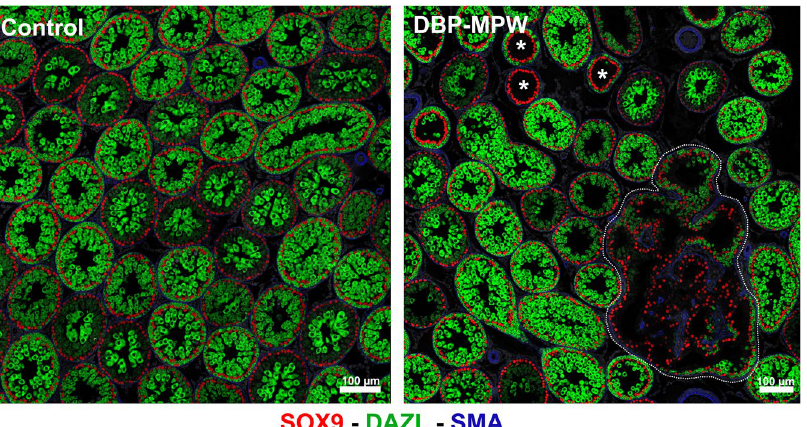
Figure 8. Identification of focal dysgenetic areas in the testes of DBP-MPW exposed animals at postnatal day 25 (Pnd25). Sections were triple immunostained for SOX9 (red, Sertoli cells), DAZL (green, germ cells), and smooth muscle actin (blue, peritubular myoid cells and some blood vessels). In the representative DBP-MPW exposed animal, a focal dysgenetic area (circled by the white dotted line), with malformed tubules and abnormal cell composition, can be seen among the normal testicular parenchyma; tubules with impaired spermatogenesis are also present (asterisks). Controls showed none of these